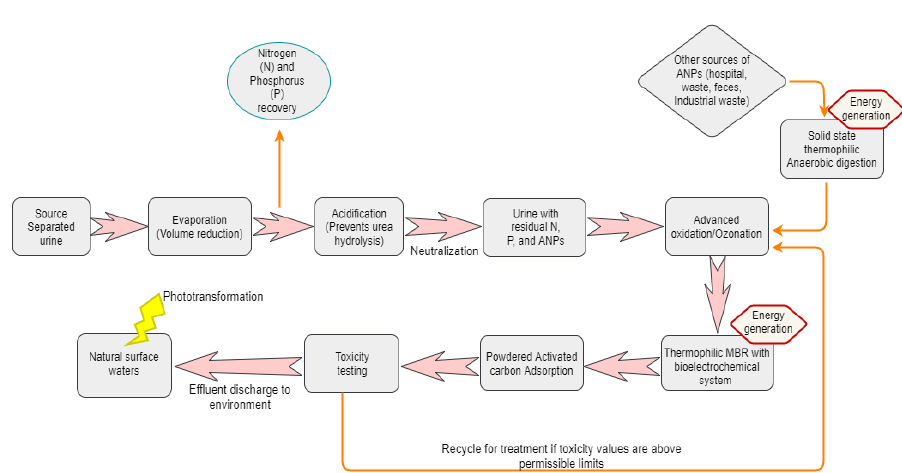
Figure 4. Proposed integrated ANP waste treatment methodology employing thermophiles.